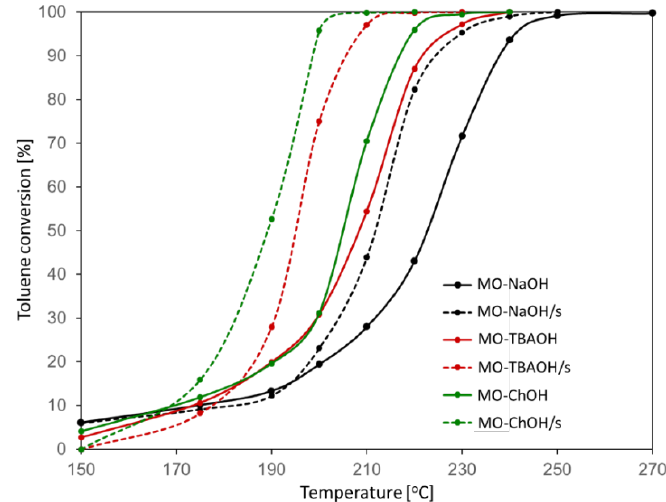
Figure 10. Ignition curves for toluene combustion over mixed oxides obtained by the calcination of precursors at 450 ◦ C. Table 2. Temperatures of 50% (T 50 ) and 90% (T 90 ) conversion of toluene in a reaction of total oxidation over mixed oxides obtained by the calcination of precursors at 450 ◦ C, and the specific surface area of the catalysts (S BET